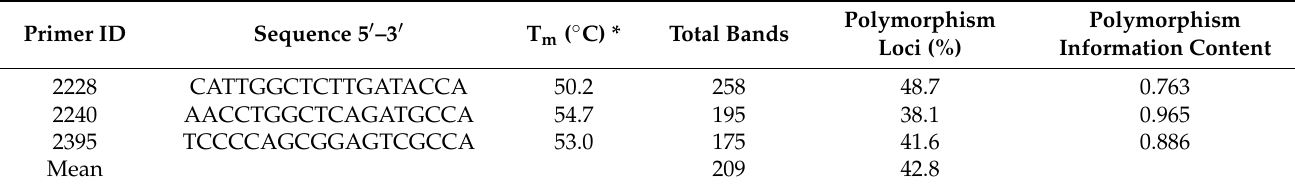
Table 1. Sequence information of primer binding sites (PBS) primers used to assess genetic diversity of A. ledebourianum and their features in the present study. Sequences of PBS primers used in this study and comparative analysis of products of iPBS amplification of the DNA of A. ledebourianum